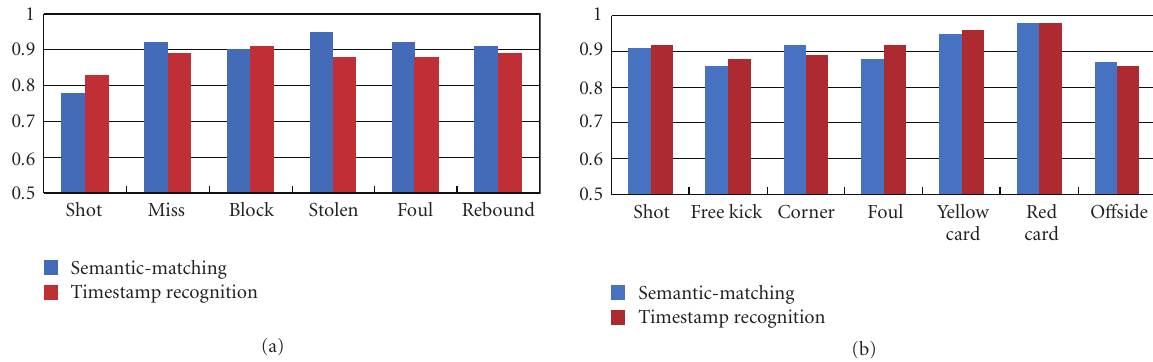
Figure 11: Comparative event detection experiments between semantics-matching and timestamp recognition methods on (a) basketball and (b) football matches.